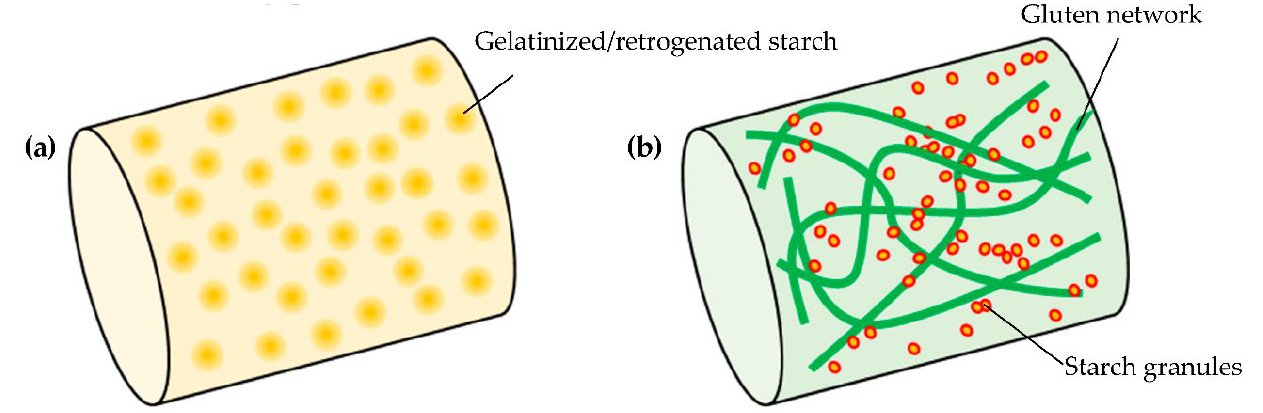
Figure 5. Schematic diagram of gluten-free pasta ( a ) and wheat pasta ( b ). Recently, a protein-rich pasta made exclusively of yellow pea and water was